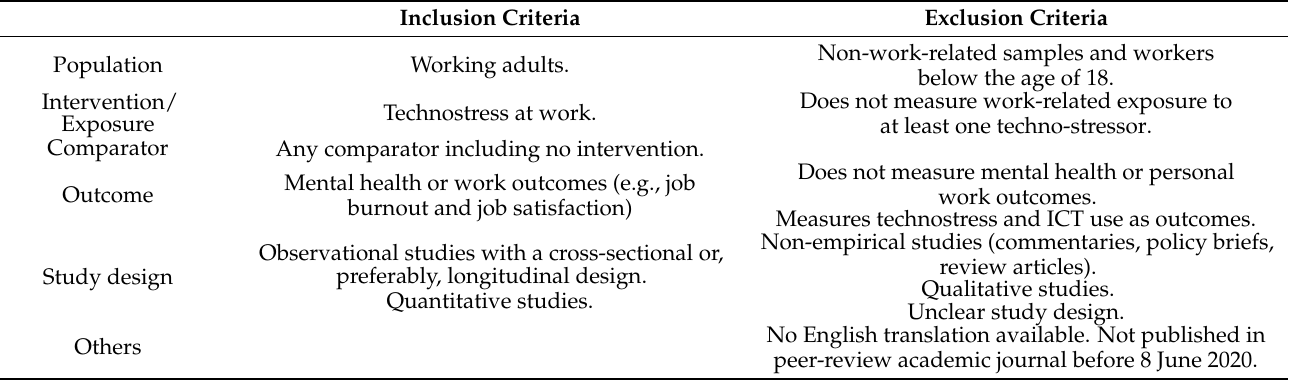
Table 1. Eligibility criteria: PICOS (population, intervention, comparator, outcome, study